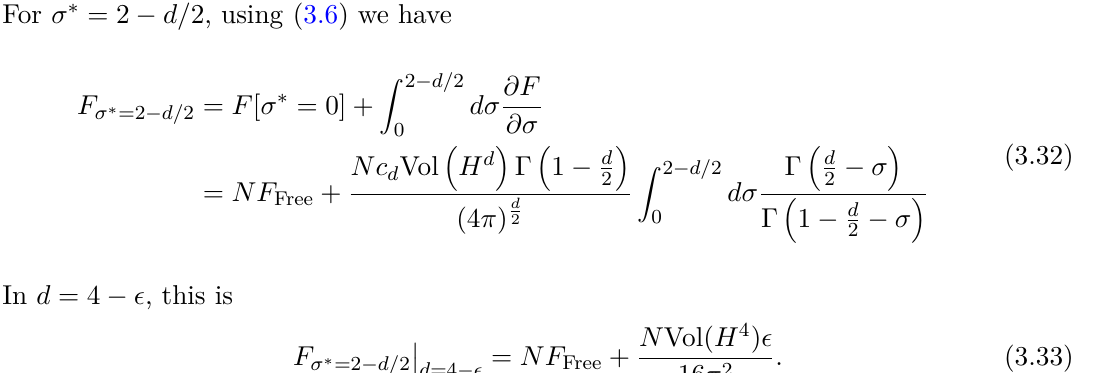
Figure 2 . The free energy difference at large N between the two phases, δ ˜ F = ˜ F where both the phases exist, i.e. between 3 < d < 4